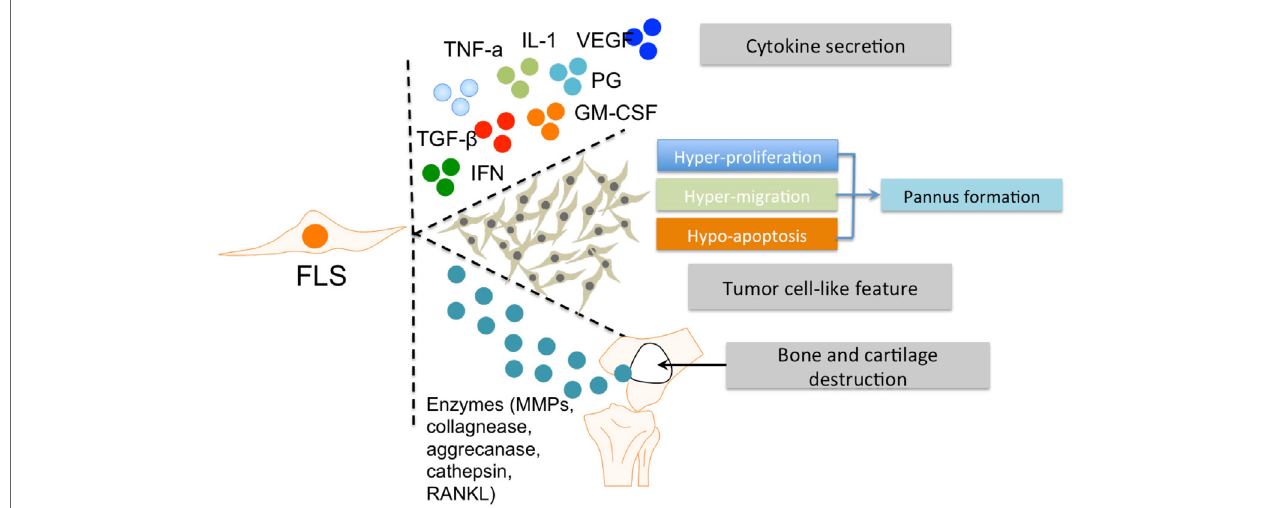
FiGuRe 2 | The roles of FLS in RA. FLS are involved in many pathological aspects of RA by promoting synovitis, pannus growth, and cartilage/bone destruction. Abbreviations: FLS, fibroblast-like synoviocytes; TNF- α , tumor necrosis factor α ; IL-1, interleukin 1; VEGF, vascular endothelial growth factor; TGF- β , transforming growth factor β ; PG, prostaglandin; IFN, interferon; GM-CSF, granulocyte-macrophage colony-stimulating factor; MMPs, matrix metalloproteinases; RANKL, receptor activator of nuclear factor kappa-B ligand; RA, rheumatoid